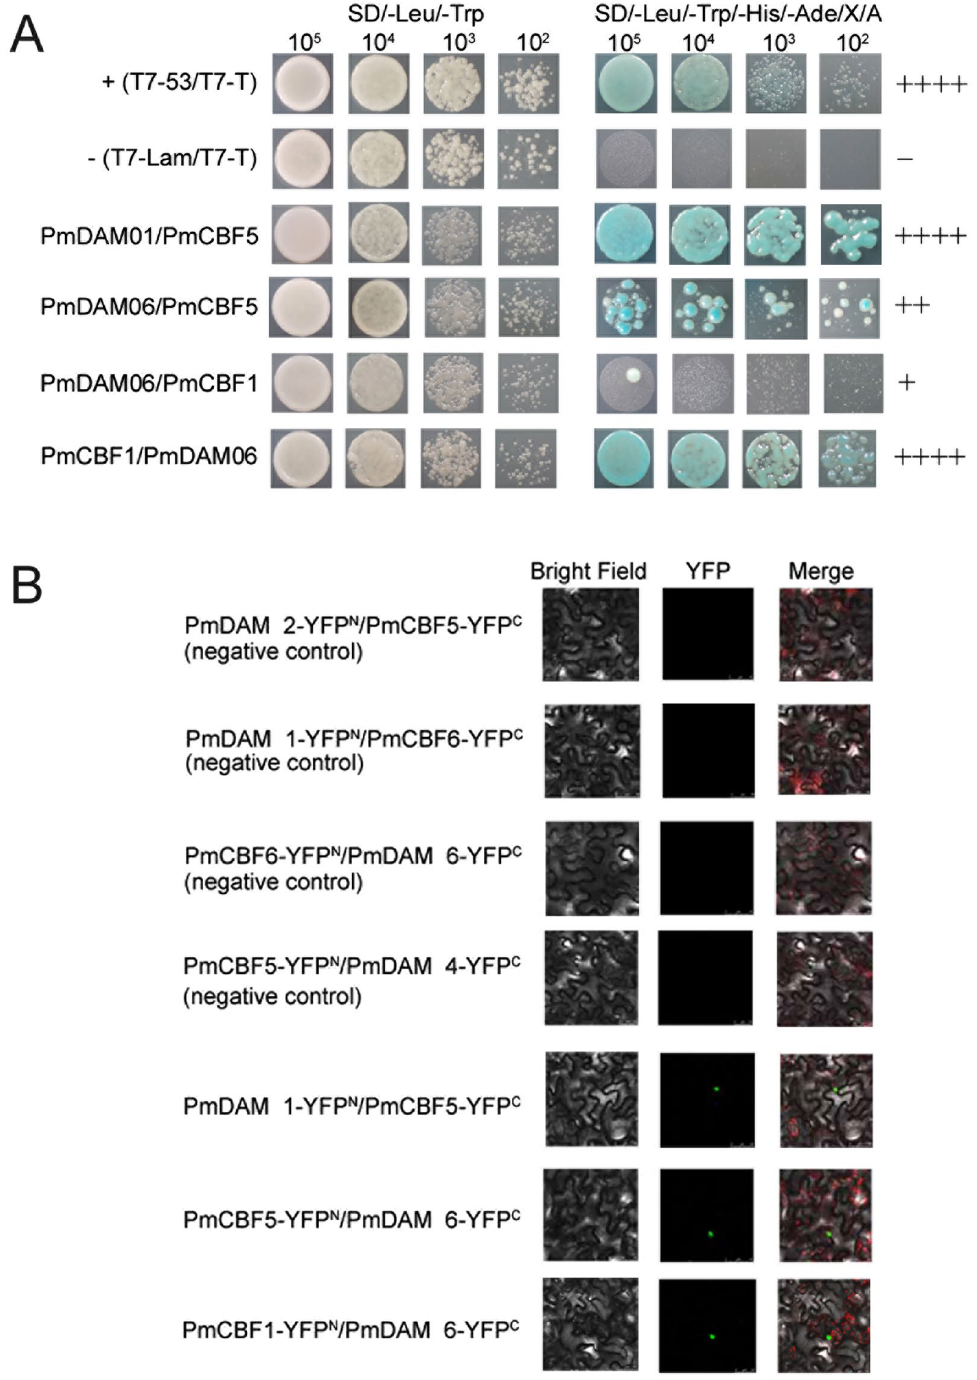
Figure 2. Protein-protein interactions between PmCBFs and PmDAMs. ( A ) Yeast two-hybrid analysis of the protein interactions between PmCBFs and PmDAMs. T7-53/T7-T was positive control, and T7-Lam/T7-T was negative control. The symbol ( + ) was represented the capacity of the reaction. The more numbers of the symbol ( + ), the more stronger capacity of the reaction. ( B ) BiFC analysis of the protein interactions between PmCBFs and PmDAMs. The green fluorescent presented protein position. The red fluorescent showed the chloroplast